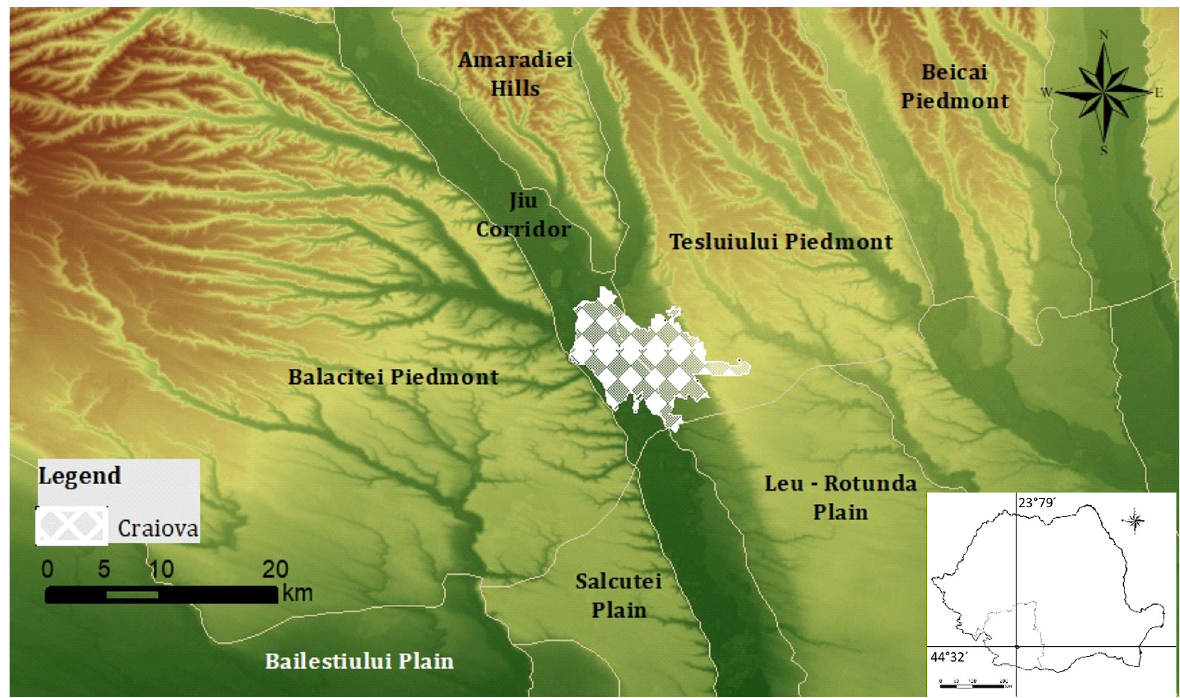
Fig. 1. The localization of the Craiova at the contact of Piemont and plain, localization on the Romania